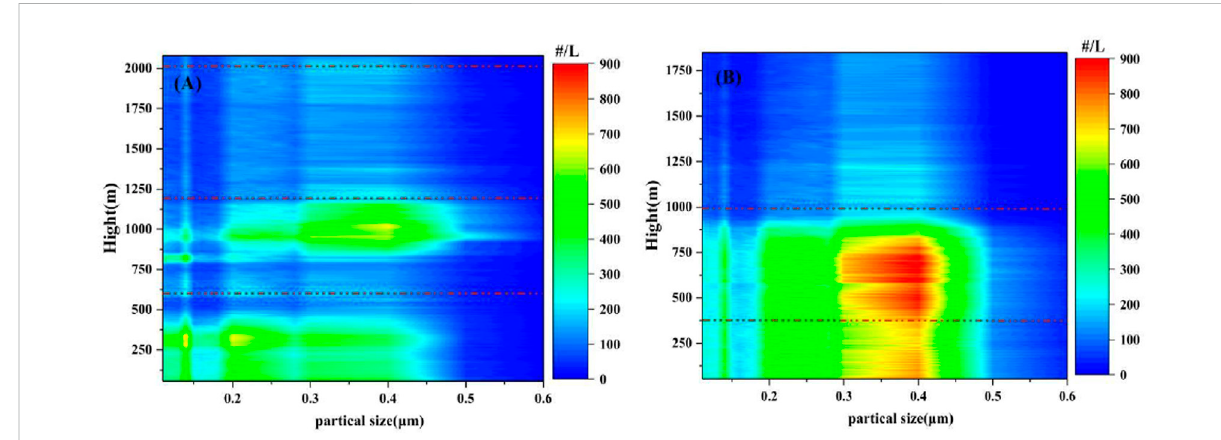
The particle size distribution of aerosols from PCASP probe during vertical soundings on November 14th (A) and 16th (B) , 2020. The black dotted lines divide the vertical altitudes into four layers based on ə θ / ə